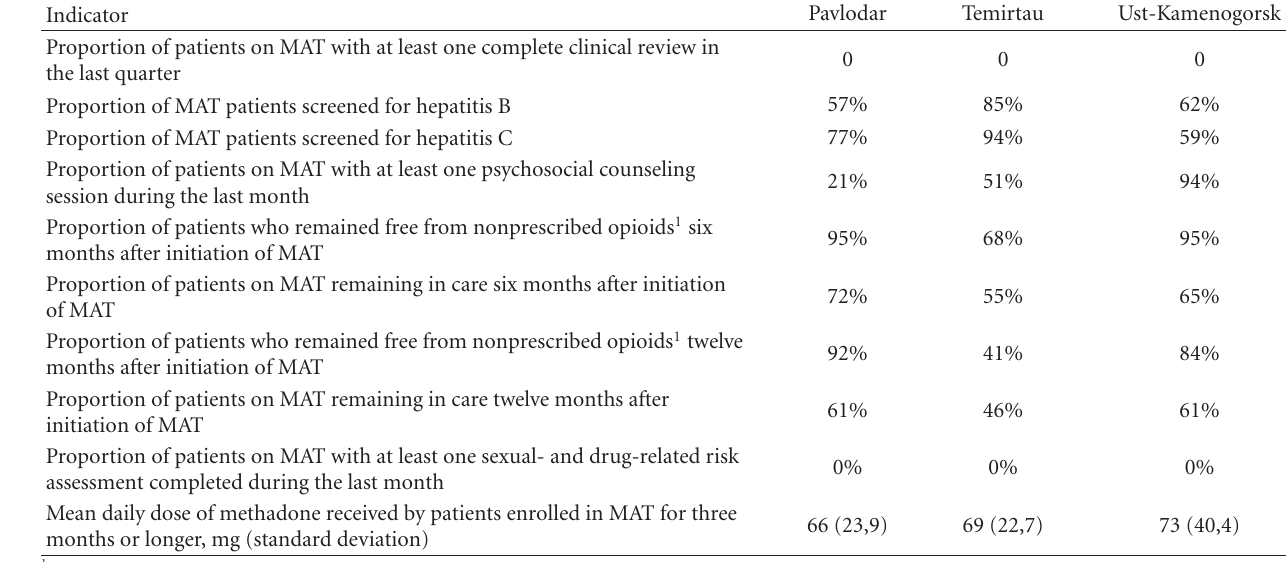
Table 3: Results of medical chart review for patients on medication-assisted therapy, by treatment site. Indicator Pavlodar Temirtau Ust-Kamenogorsk Proportion of patients on MAT with at least one complete clinical review in Proportion of MAT patients screened for hepatitis B Proportion of MAT patients screened for hepatitis